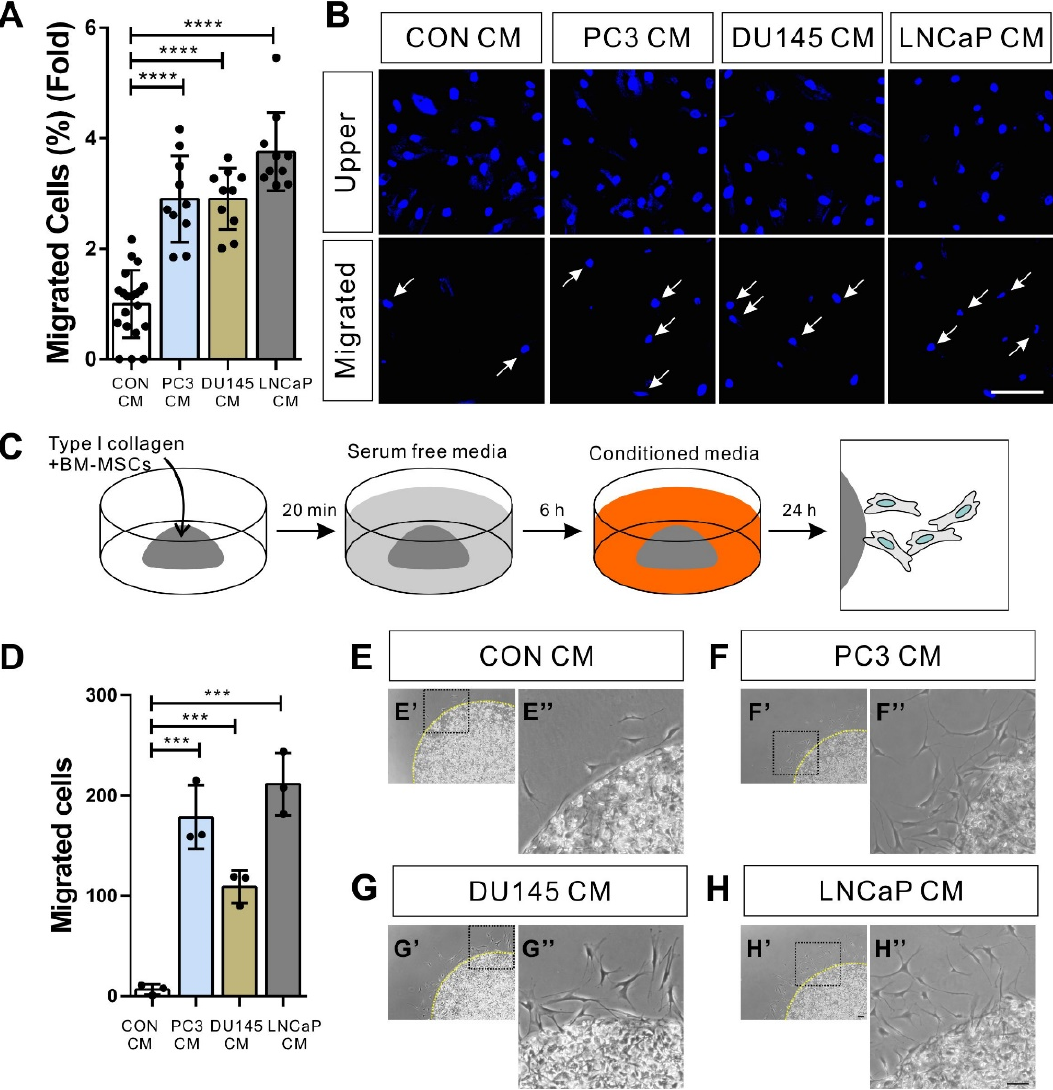
Figure 1. Bone marrow-derived mesenchymal stem cells (BM-MSCs) migrate toward the prostate tumor cell-conditioned medium. ( A , B ) Migration of BM-MSCs in response to the control-conditioned medium (CON CM), the PC3-conditioned medium (PC3 CM), the DU145-conditioned medium (DU145 CM) or the LNCaP-conditioned medium (LNCaP CM). Results are presented as the mean ± SD ( n = 2 samples for each group, 4 independent experiments). White arrows indicate DAPI-stained nuclei of migrated BM-MSCs on the lower membrane surface. ( C ) Schematic representation of 3D migration assay. ( D – H ) Three-dimensional migration of BM-MSCs toward CON CM, PC3 CM, DU145 CM, or LNCaP CM. Results are presented as the mean ± SD ( n = 3 samples for each group, 3 independent experiments). Black dotted boxes in E’, F’, G’, and H’ are magnified in E”, F”, G”, and H”, respectively. Yellow broken lines indicate the margin of collagen gel. Scale bars indicate 100 µm. p -Values were obtained by t -test (*** p ≤ 0.001; **** p ≤ 0.0001).